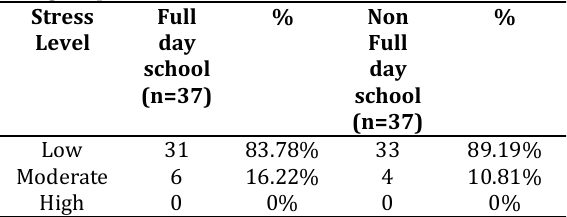
Table 2 Distribution of Stress Levels inStudents in